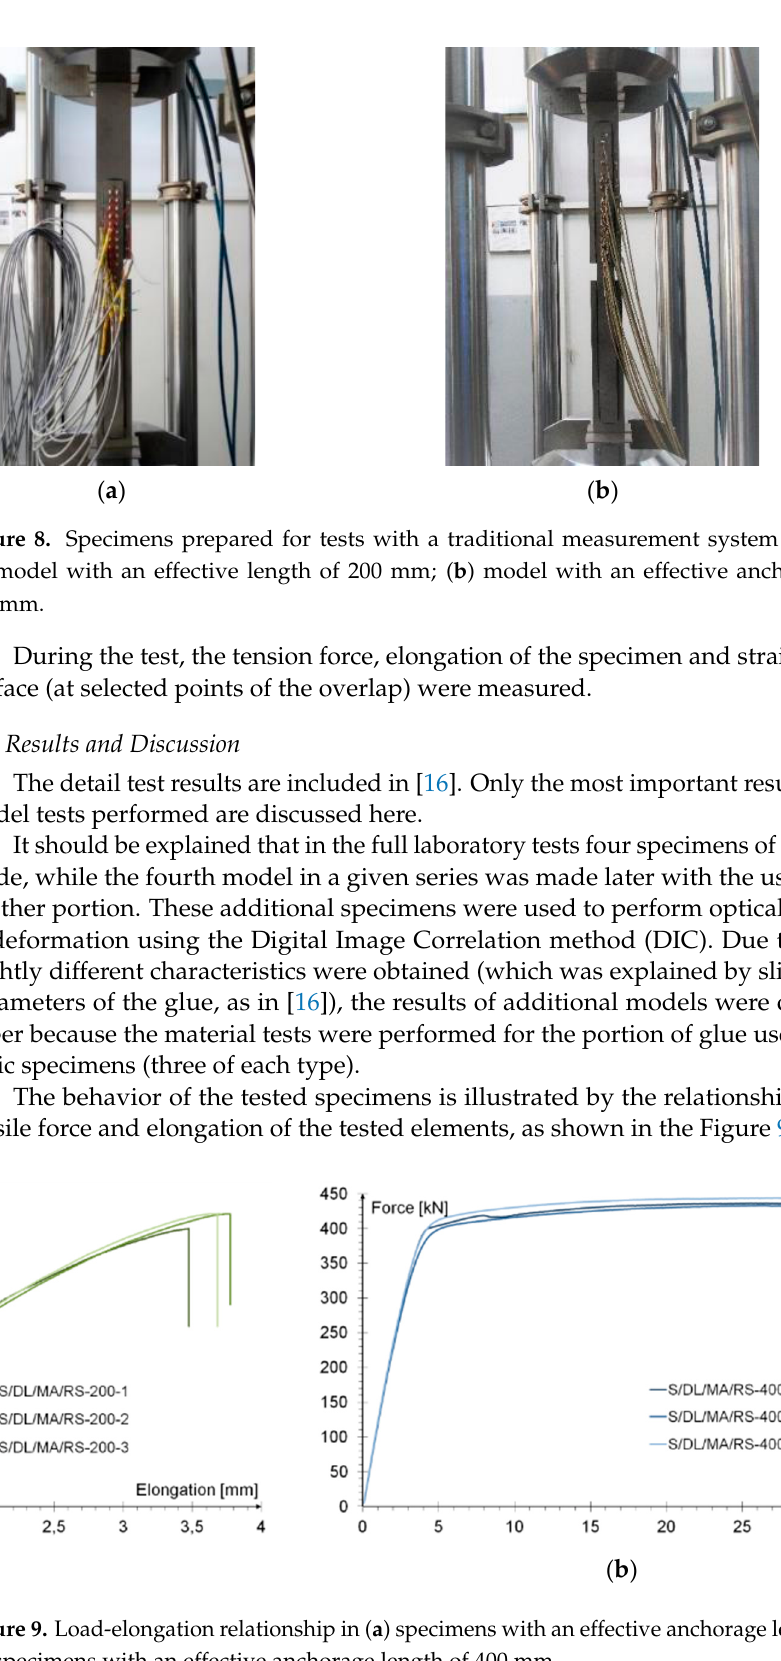
( b ) Figure 10. Specimens after failure: ( a ) model with an effective anchorage length of 200 mm; ( b ) model with an effective anchorage length of 400 mm. In elements with an effective joint length of 400 mm, two work phases were distin- guished: elastic and plastic. The yielding of the specimens took place at an average force of 403 kN, and the strain averaged over the length of the sample was 0.52%. During the plastic phase, the elongation of the samples increased very rapidly. At failure, it exceeded 30 mm, which corresponded to the average strain of the models amounting to 3.73%. The force during yielding process increased slightly and at the time of failure amounted to ca. 437 kN. Measurement of the length of steel elements after failure allowed for the conclu- sion that the steel base elements had plasticized, which was also confirmed by subsequent tests in which the optical method of measuring deformation of steel surfaces was used [16]. Unfortunately, due to the limitations of the measurement methods, it cannot be clearly determined to what extent the adhesive had plasticized. The damage of the joint was carried out in two stages. From the point of view of the ASTM standard [48], at the moment of steel yielding the joint was damaged because one of the system components was theoretically destroyed (sudden increase in deformation). So, “metal failure” oc- curred in this convention. However, after the steel yielded, the joint deformation